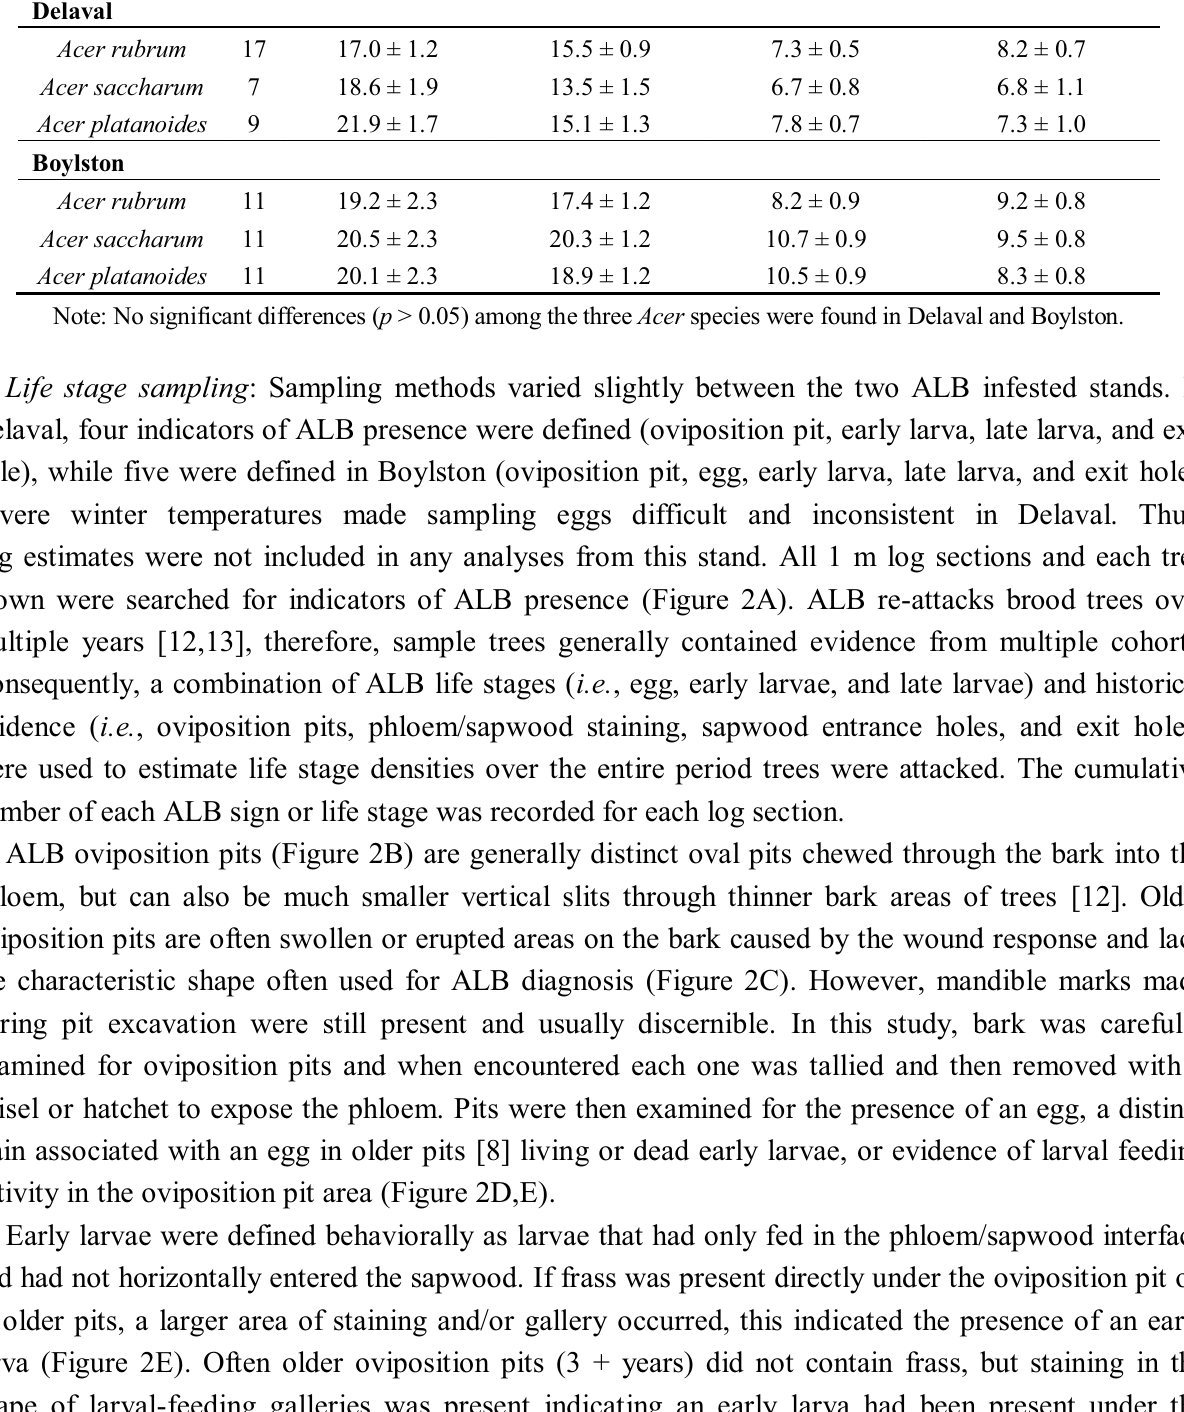
Table 1. Mean (±SE) diameter, total height, bole length, and crown length of trees sampled for Asian longhorned beetle in Delaval (2009) and Boylston (2010). Mean Diameter Species N